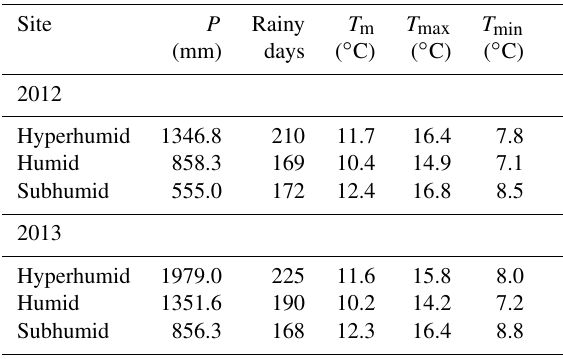
Table 1. Climatic information on the study sites in 2012 and 2013.